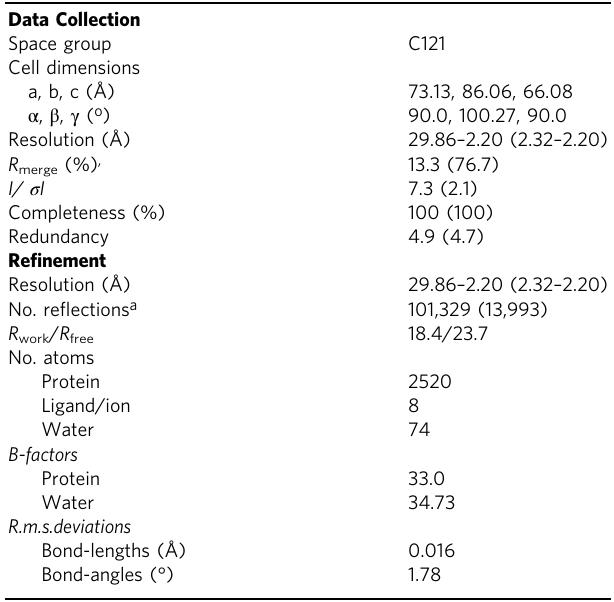
Table 1. The hCEACAM1 oligomer crystal structure revealed three hCEACAM1 molecules (a, b, c) in the asymmetric unit (Fig. 1a and Supplementary Fig. 1a – c) that exhibited an overall